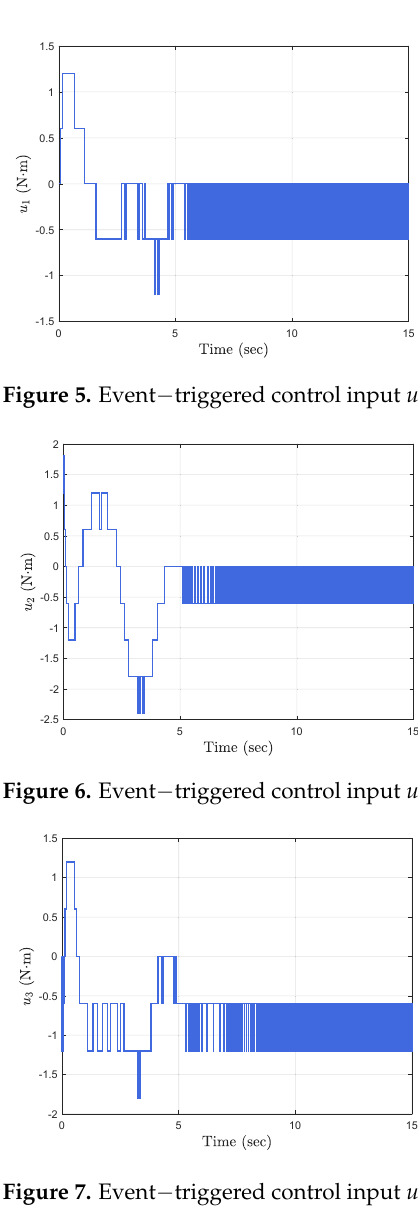
Figure 7. Event − triggered control input u 3 .